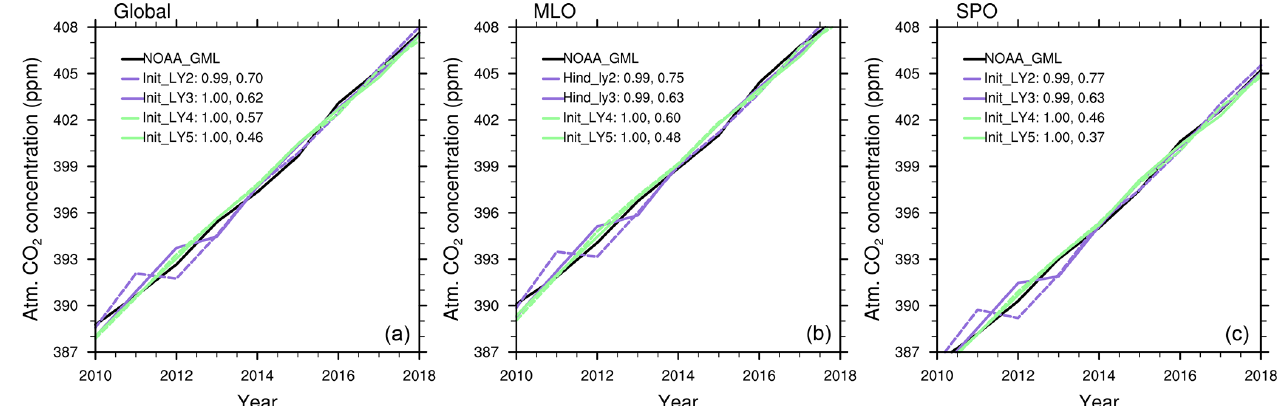
Figure A6. The same as Fig. A5 but with bias-corrected mean states and linear trends.